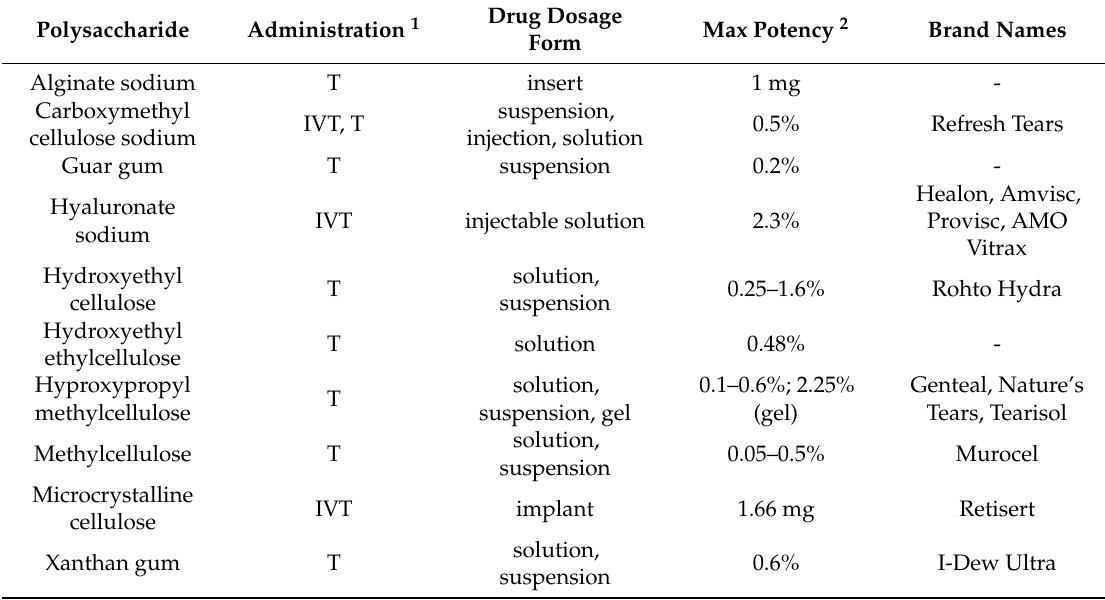
Table 1. List of FDA-approved polysaccharides used as excipients for ophthalmological drugs [22].